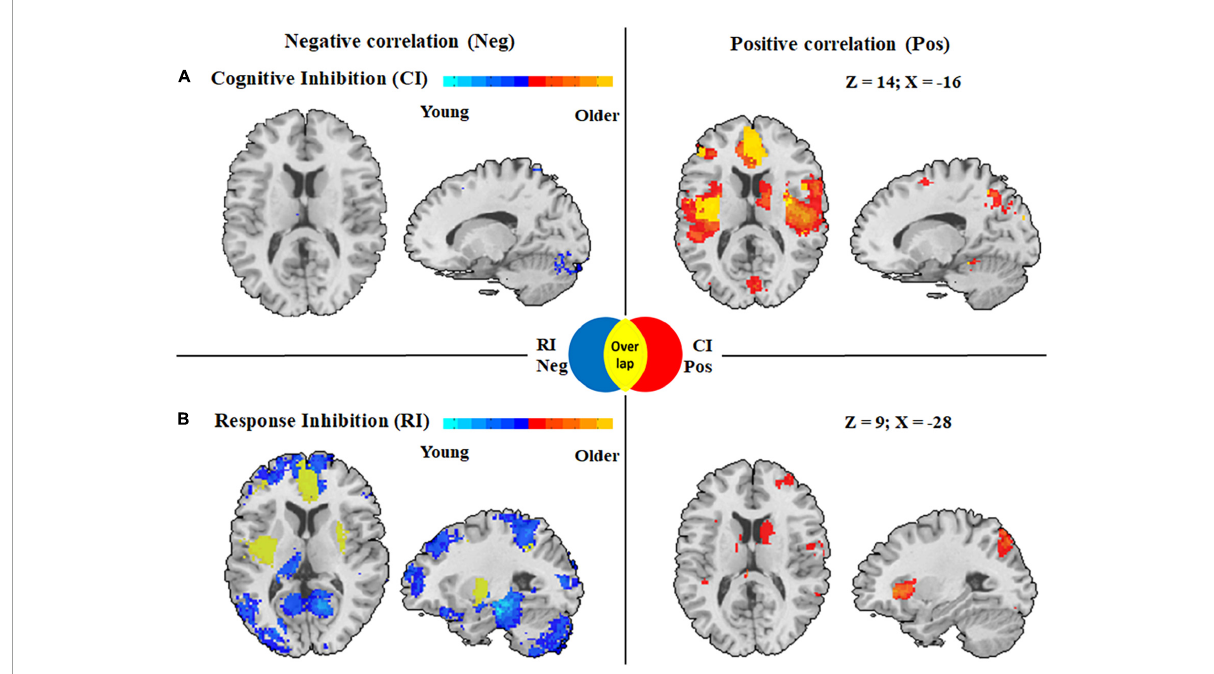
FIGURE4 Activation maps displaying whole brain regression analysis in cognitive inhibition and response inhibition with age as a covariate. (A) Correlation with age with clusters in cognitive inhibition. (B) Correlation with age with clusters in response inhibition. Clusters associated with activity in older adults during inhibitory control are displayed in red, whereas clusters associated with activity during inhibitory control among younger adults are displayed in blue. CI Pos: Regions associated with increased activity with aging during cognitive inhibition; RI Neg: Regions associated with decreased activity with aging during response inhibition; Overlap: Regions displayed in yellow derived from overlapping results from regression analyses in two subcomponents with age, meaning a distinct correlation with age in these regions in two subcomponents of inhibitory